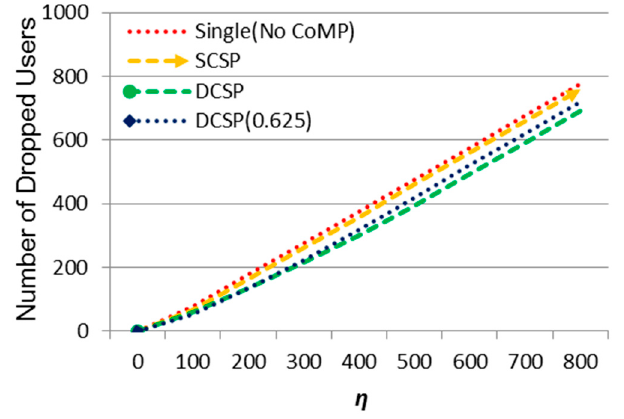
Figure 7. The effect of η on the number of dropped users. Figure 8. The effect of η on average cluster size.